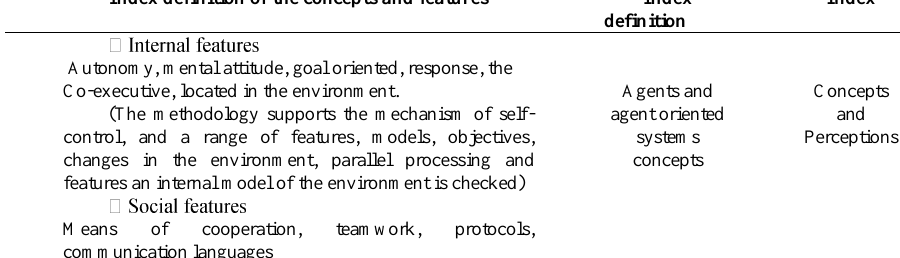
Table 2. Concepts and properties covered with evaluation framework indexes.